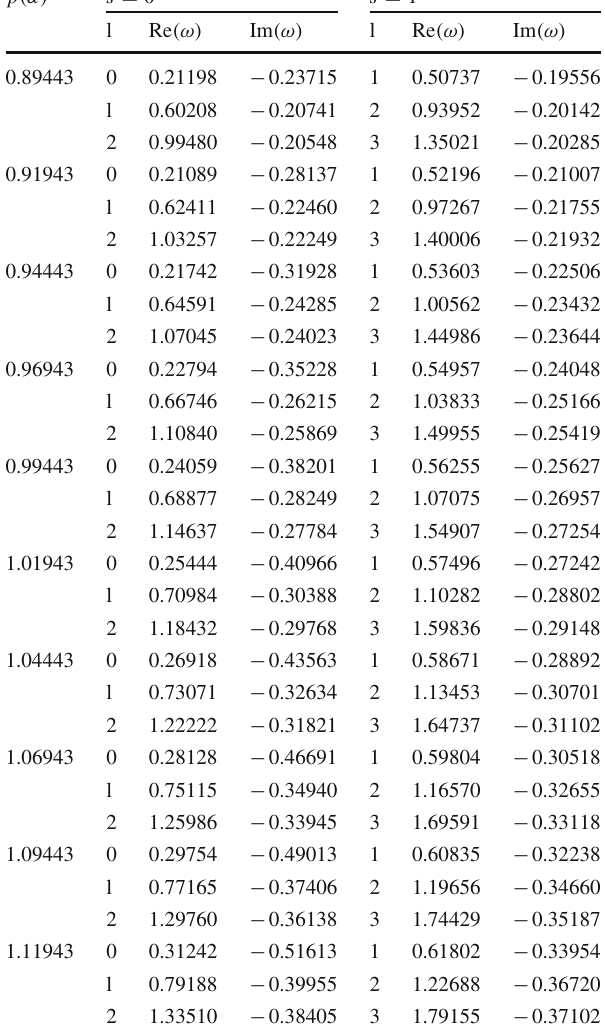
Table 3 Values of the quasinormal frequencies obtained with the help of the sixth WKB order formula (13) with n = 0, r 0 = 1 ; l = 0 , 1 , 2 for s = 0 and l = 1 , 2 , 3 for s =